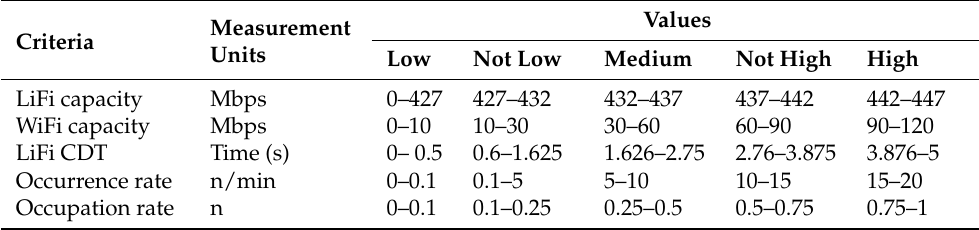
Table 3. Criteria values used for the decision matrix.